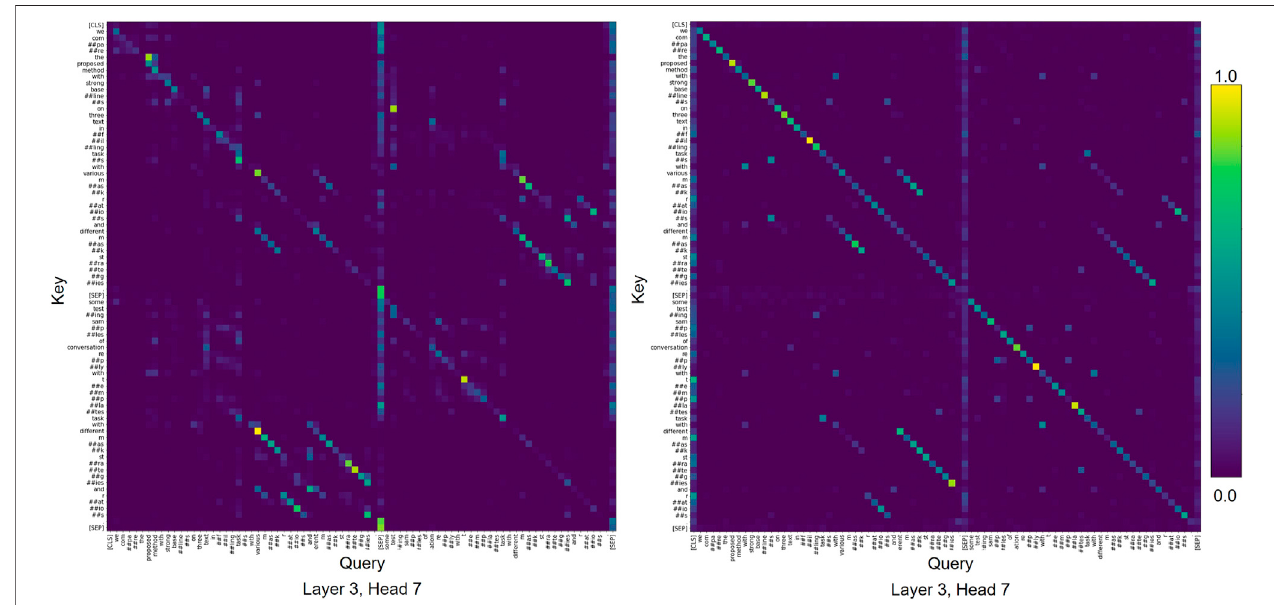
FIGURE 7 | Examples of attention patterns in vanilla BERT model for higher-ranked sample.